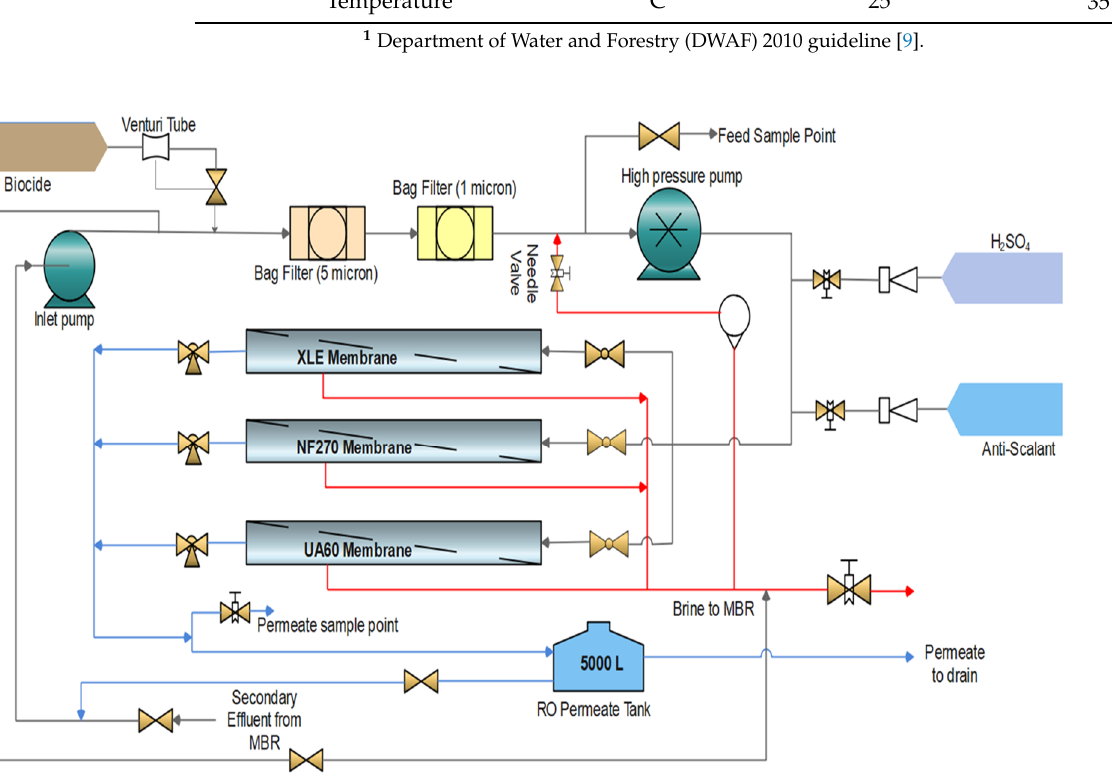
Table 2. The physicochemical characteristics of the membrane bioreactor (MBR) effluent.